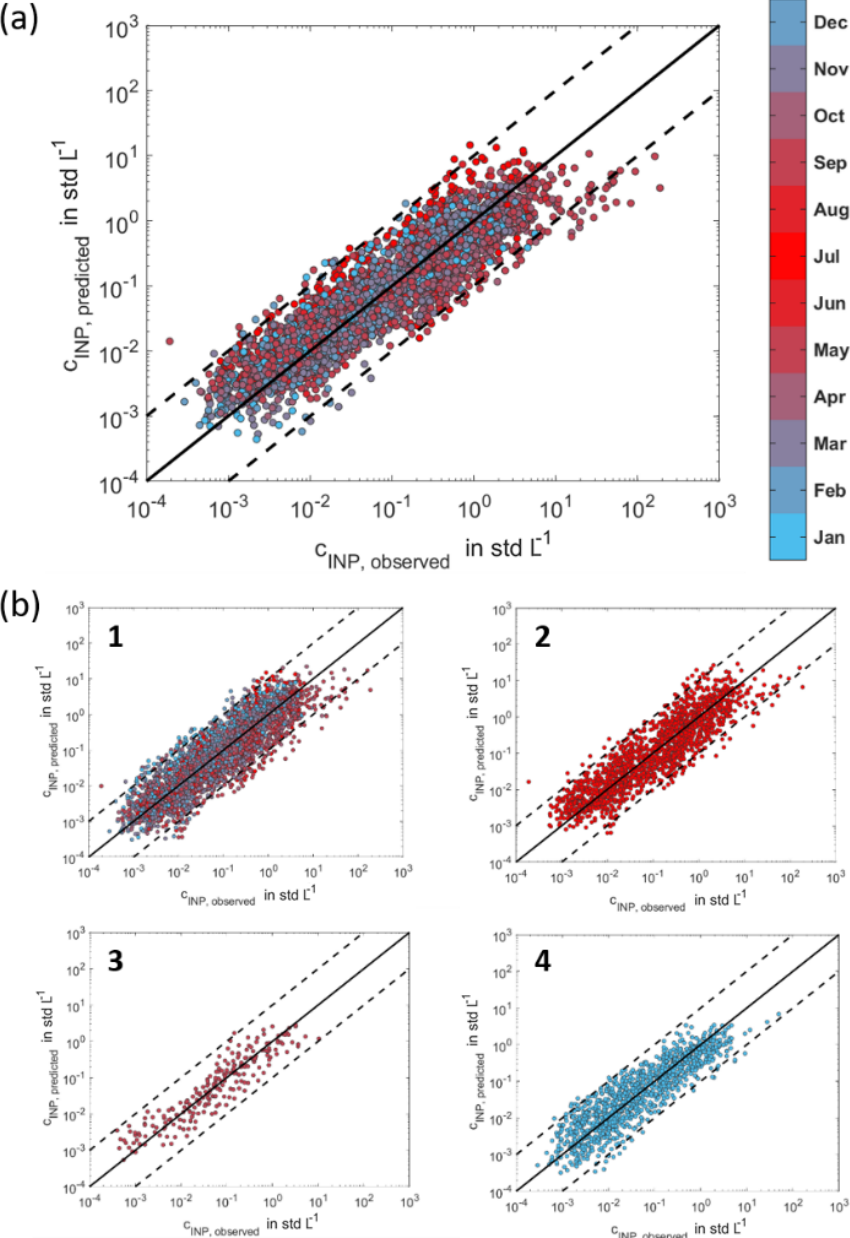
Figure 8. New INP parameterizations for boreal forest INPs. Panel (a) shows INP concentrations predicted by our new parameterization, using ground-level ambient air temperature compared to measured INP concentrations colour-coded with the corresponding month. In panel (b) , the measurements are compared to the predictions of the new INAS density parameterization. The four panels show the new INAS parameterization for the boreal forest INP over the whole year (1), only describing summertime INPs (2), the parameterization for the transition period (3) and the formulations for boreal INPs in wintertime